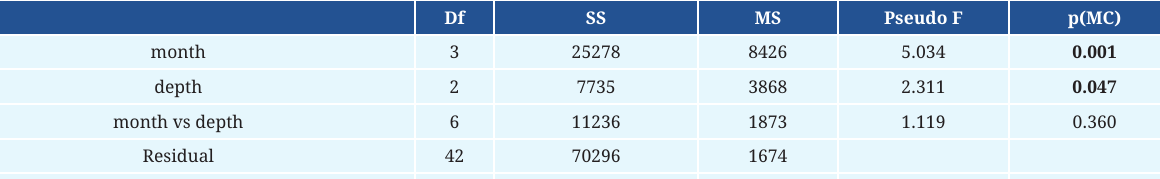
TABLE 2 | PERMANOVA results showing the effects of qualitative variables (month and depth) in the structure of larval fish community and their interaction. P(MC) : p-value of the Monte Carlo permutation test. SS : Type III square sum, Df: The degree of freedom, MS: Mean sum of square. Df SS